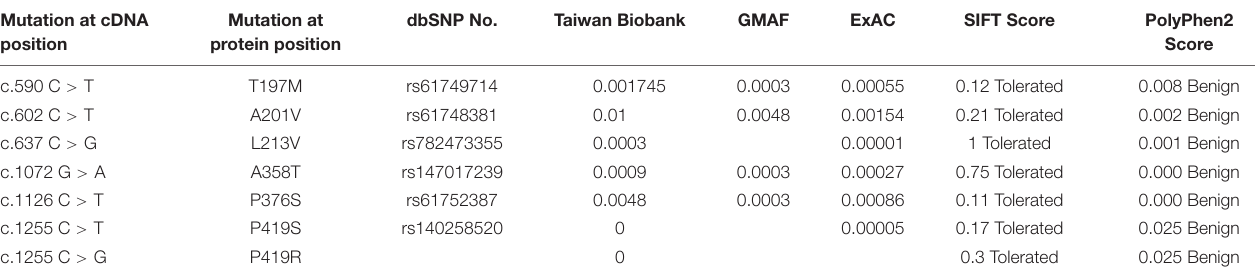
TABLE 3 | Allele frequency and functional prediction of MECP2 missense mutations identified in this study. Mutation at cDNA Mutation at dbSNP position protein position